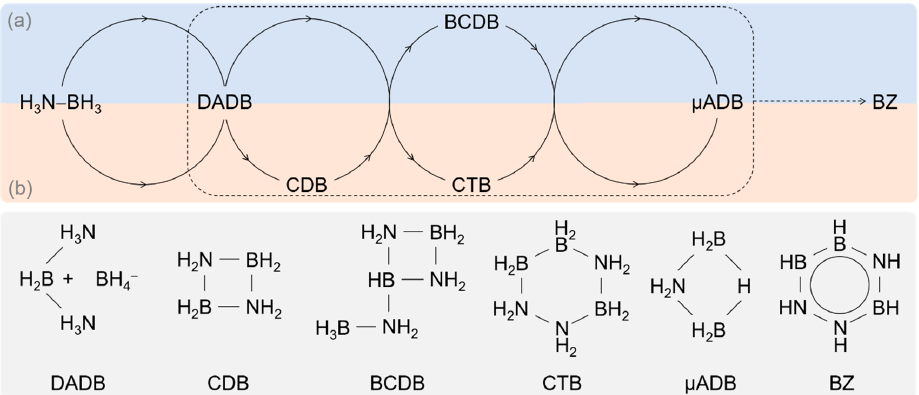
Energies 2020 , 13 , x FOR PEER REVIEW 16 of 45